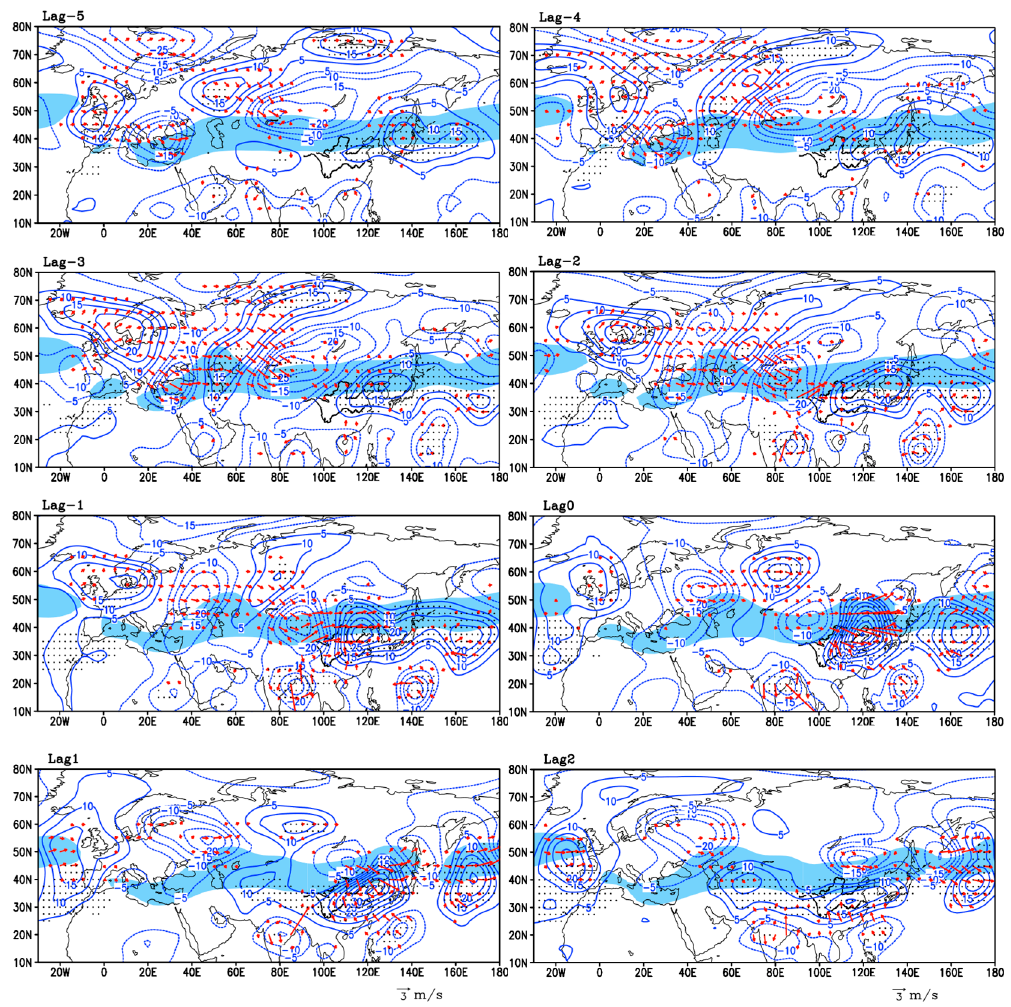
Figure 13. Composites of the Lag − 5 day to the Lag +2 day 500 hPa geopotential height (contour, gpm) and 300 hPa Rossby wave activity (vector, m 2 /s 2 ) for the REP events. The gray dots indicate the 95% confidence level.